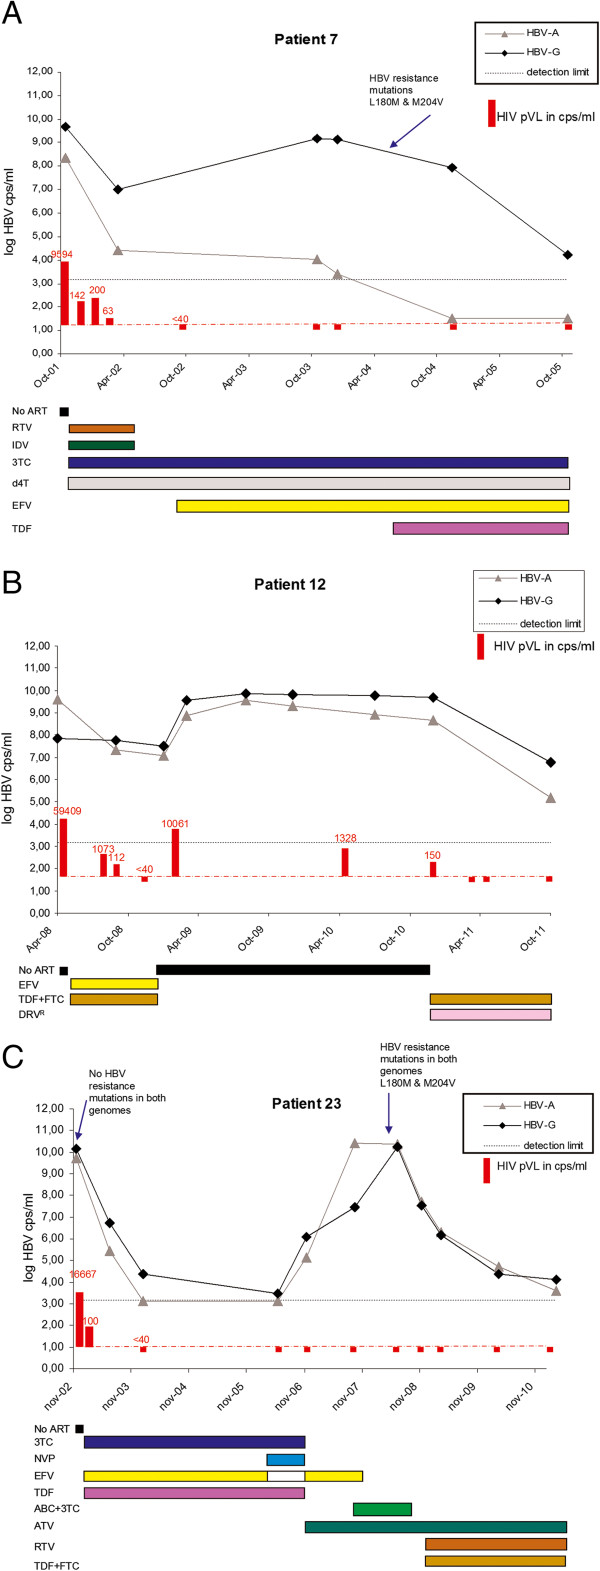
Longitudinal analysis of the HBV-A and -G pVL in three male HIV-1 infected patients. Panel A = patient 7; panel B = patient 12; panel C = patient 23. The HIV-1 pVL is indicated with red bars; numbers in red are HIV-1 copies/ml. ART regimens are shown below the graphs. Abbreviations: 3TC = lamivudine; ABC = abacavir; ATV = atazanavir; d4T = stavidine; DRV = darunavir (boosted with RTV); EFV = efavirenz; FTC = emtricitabine; IDV = indiniavir; NVP = nevirapine; RTV = ritonavir; TDF = tenofovir. 3TC and TDF are also effective against HBV.